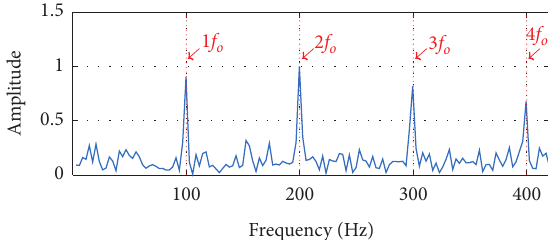
Figure 6: Results of the proposed method.